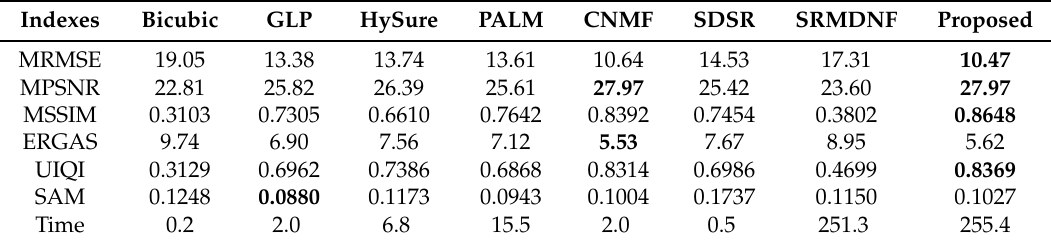
Table 3. Quantitative results on the Paris dataset with a magnification factor of 3.